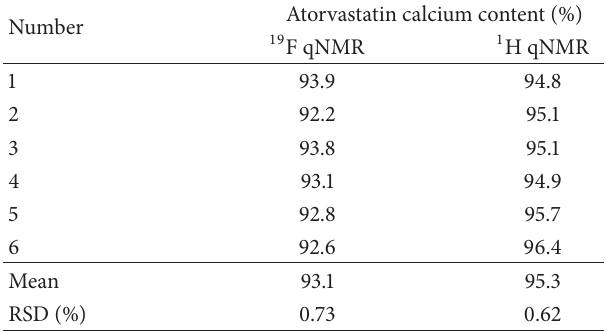
Table 2: Content of atorvastatin calcium calculated from 19 F and 1 H qNMR